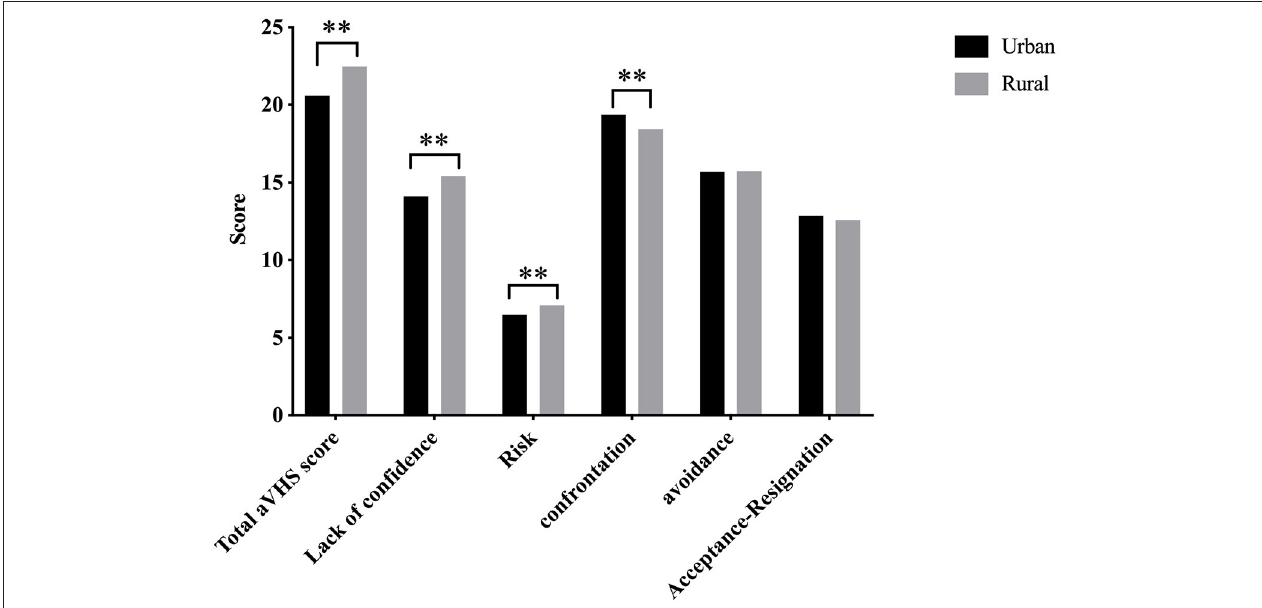
FIGURE 1 | Comparison of vaccine hesitancy and coping styles of NMOSD patients according to urban/rural. ** P <